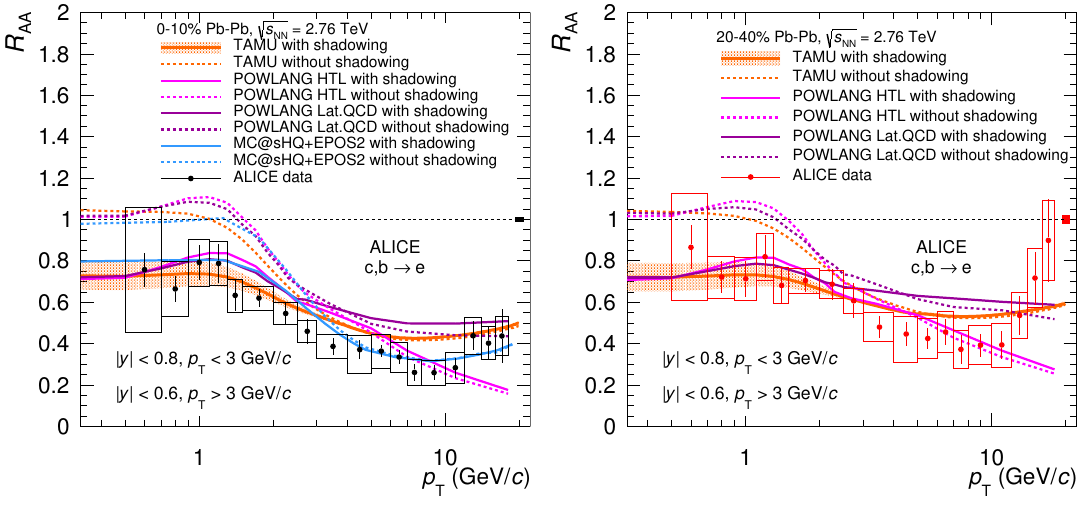
Figure 5 . R AA of electrons from semileptonic heavy-(cid:13)avour hadron decays at mid-rapidity as a function of p T in 0{10% (left) and 20{40% central (right) Pb{Pb collisions at compared to model calculations [82] with and without EPS09 shadowing parameterisations [34].